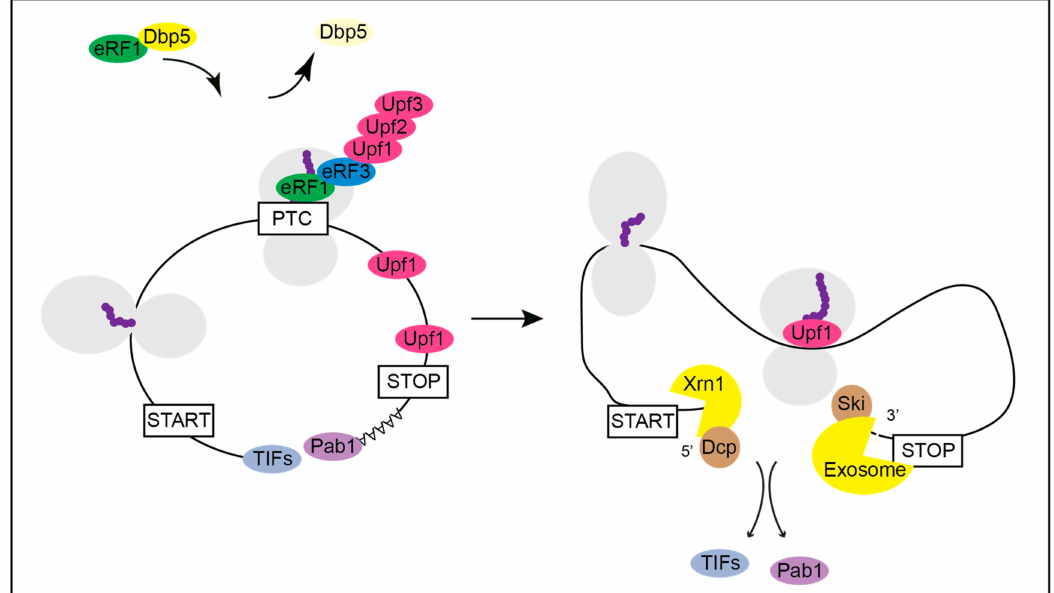
Figure 4. Termination at a premature termination codon (PTC) and the subsequent initiation of the nonsense mediated decay (NMD) of the mRNA. Under normal conditions yeast Dbp5 promotes the stop codon recognition by eRF1 and eRF3 also at a PTC. However, when recognized as premature by the NMD machinery, Upf1 binds to the release factors and assembles the Upf1-2,3 complex. Consequently, further translation is inhibited, and downstream factors are recruited to promote rapid mRNA decay. The decapping factors Dcp1 and Dcp2 and Xrn1 act from 5 (cid:48) to 3 (cid:48) and the Ski complex and the exosome degrade the PTC-containing mRNA from 3 (cid:48) into 5 (cid:48)